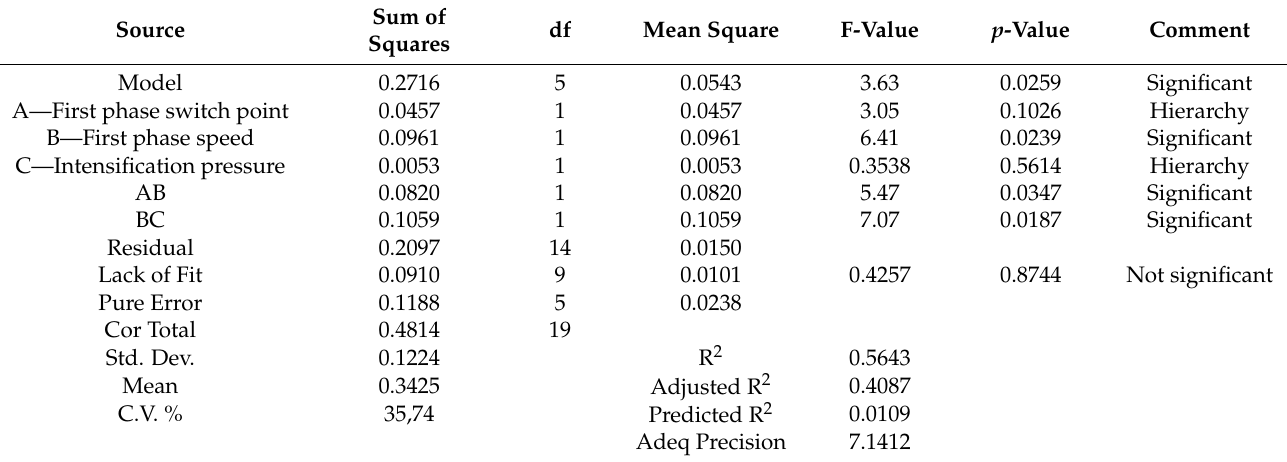
Table 4. ANOVA total rejection